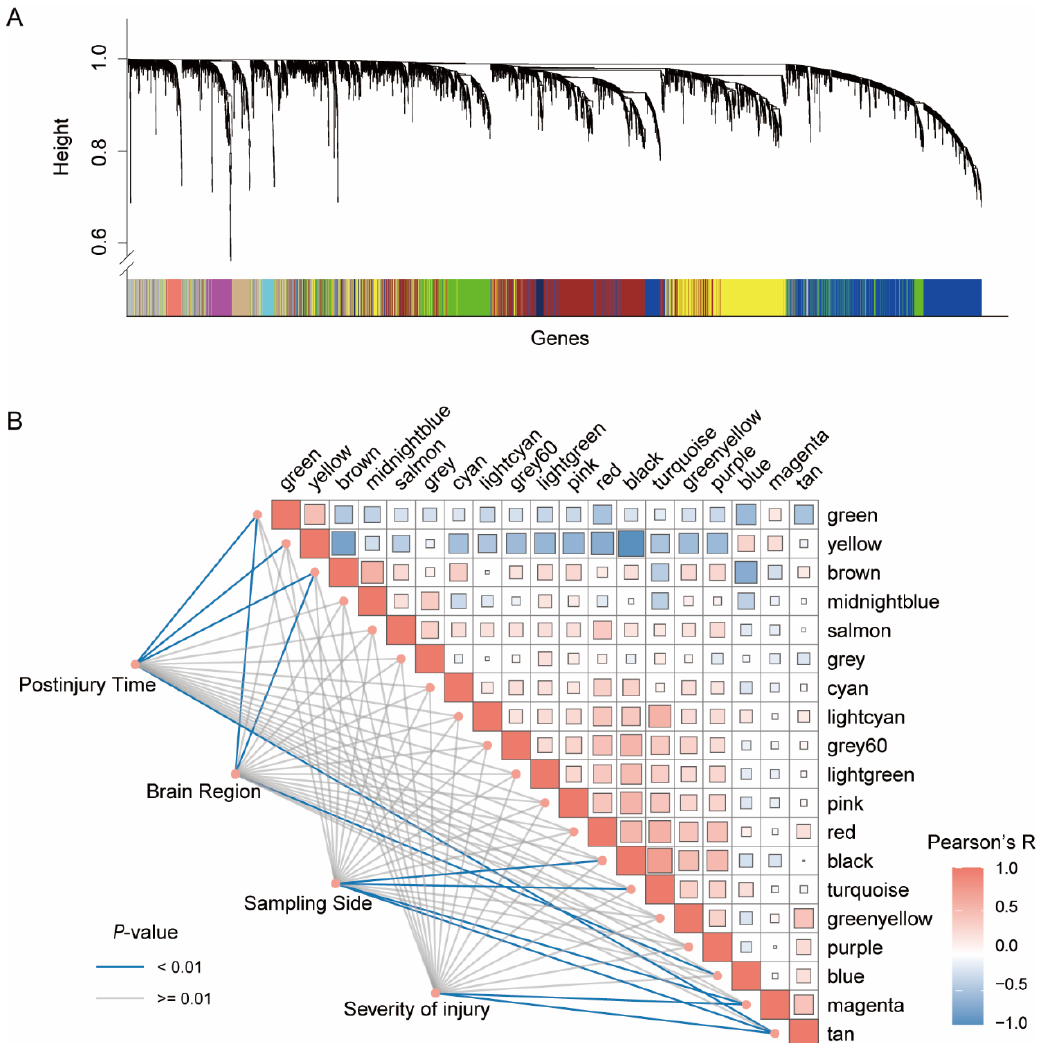
Figure 1. WGCNA of the rat TBI Dataset GSE2871. ( A ) Hierarchical clustering tree of genes, with dissimilarity based on the topological overlap. Each gene cluster (module) is marked with a different color. ( B ) Identification of key modules related to sample traits. Heatmap illustrating the intramodular relationship. Rows and columns correspond to modules, and each cell contains the corresponding correlation and p -value. Pearson’s R-values are color-coded according to the color legend. The size of the rectangle is proportional to the p -value; the larger the rectangle, the more significant the correlation. The color of the line represents the correlation significance between traits and modules.